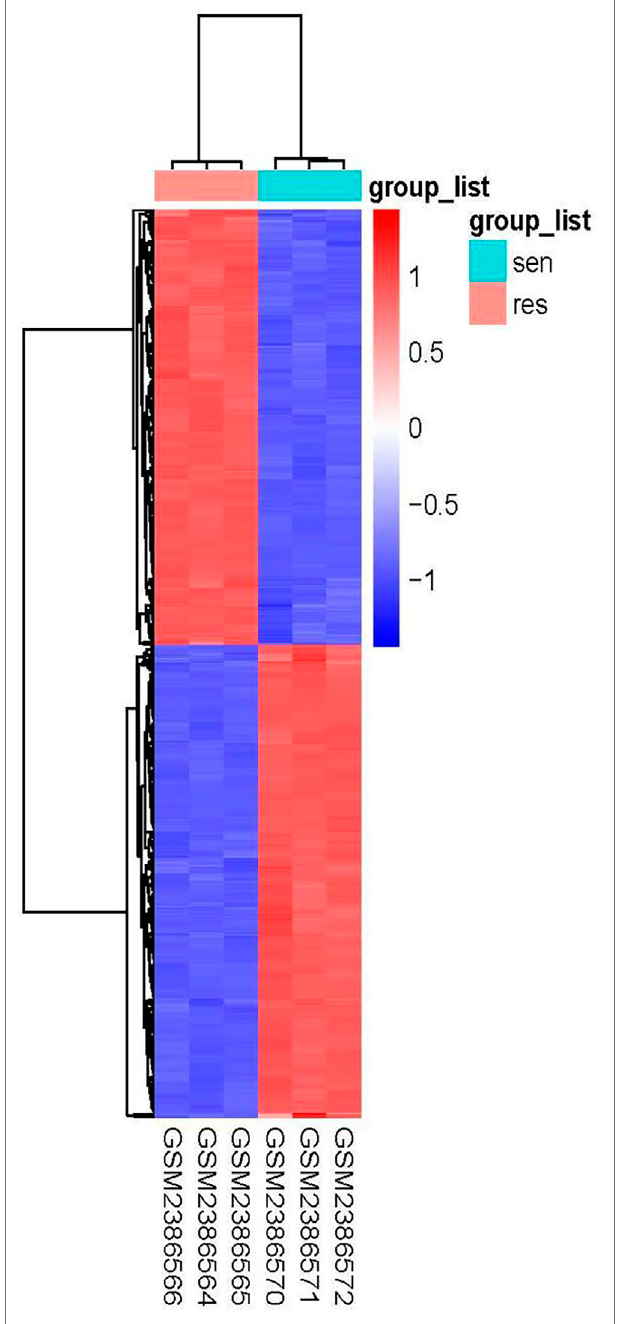
FIGURE 2 | Heatmap of differentially expressed genes in GIST882 and GIST430 data sets.